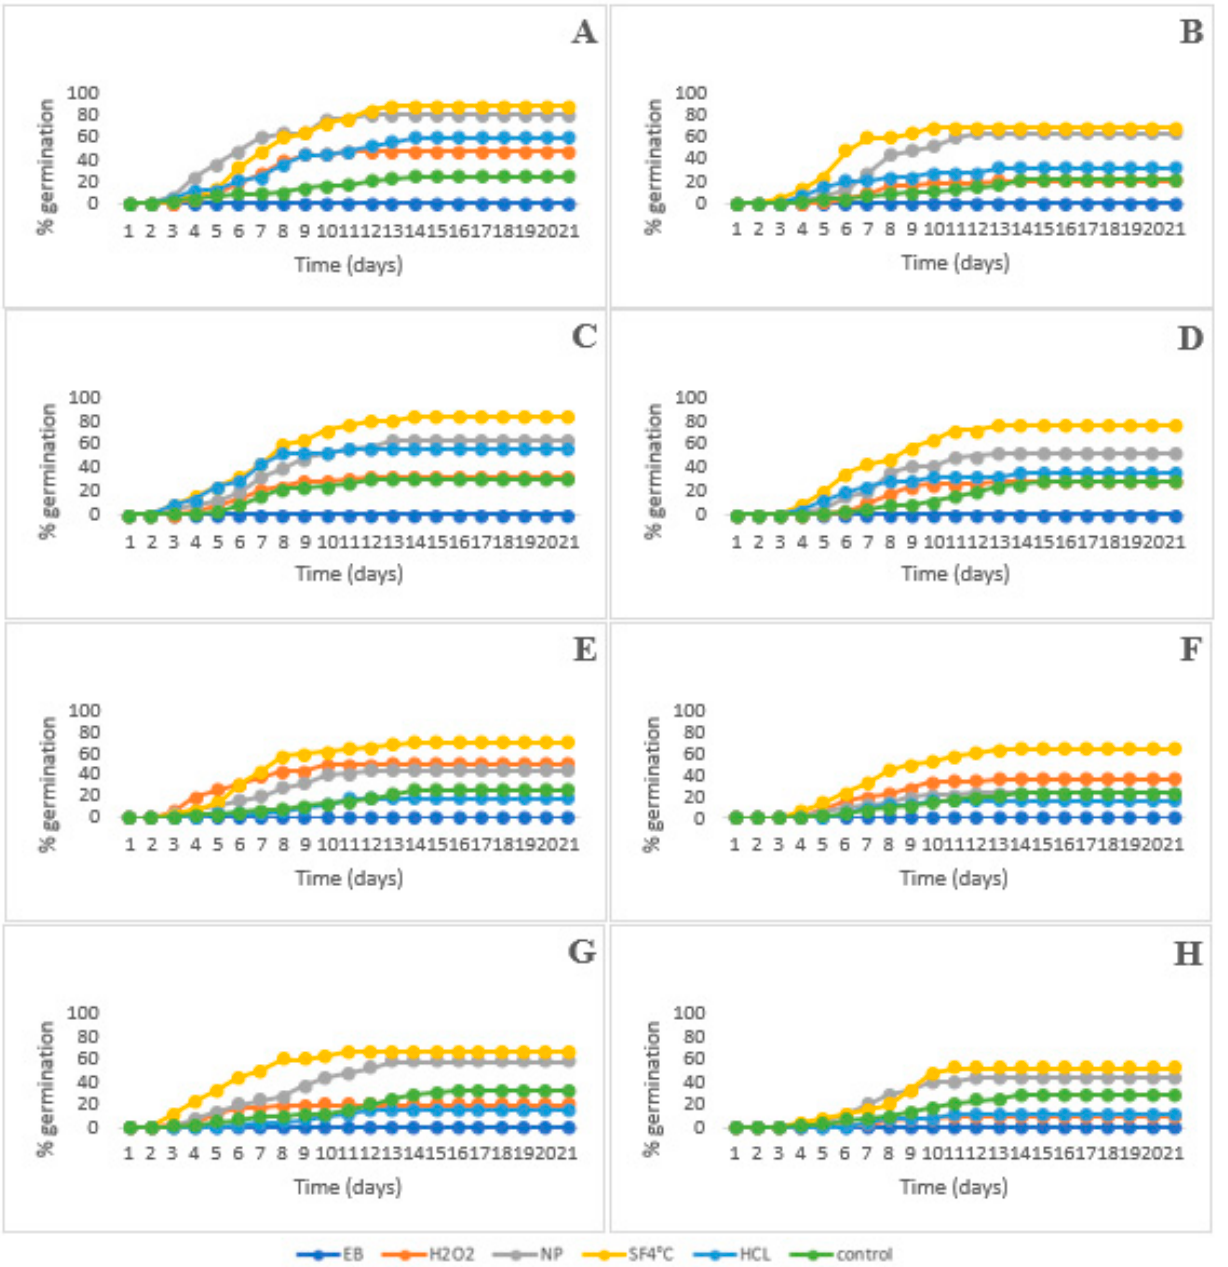
Figure 3. Germination kinetics of the two studied varieties germinated on soil and filter paper (FP), according to different pre-treatments (EB: boiling water, H 2 O 2 : hydrogen peroxide, NP(KNO 3 ): potassium nitrate; SF 4 °C: cold scarification 4 °C; H 2 SO 4 : sulphuric acid). ( A ) peripheral seeds of A. P var. pyrethrum germinated on filter paper; ( B ) peripheral seeds of A.P var. pyrethrum germinated on soil; ( C ) central seeds of A. P var. pyrethrum germinated on filter paper; ( D ) central seeds of A.P var. pyrethrum germinated on soil; ( E ) peripheral seeds of A.P var. depressus germinated on filter paper; ( F ) peripheral seeds of A.P var. depressus germinated on soil; ( G ) central seeds of A.P var. depressus germinated on filter paper; ( H ) central seeds of A.P var. depressus germinated on soil.